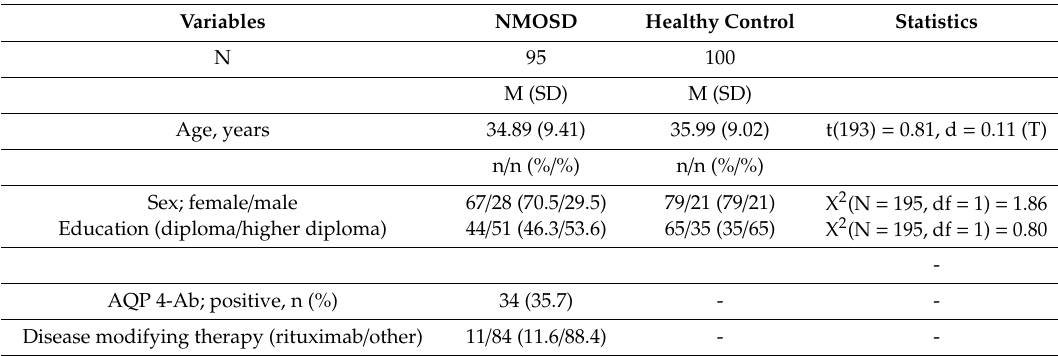
Table 1. Demographic and clinical